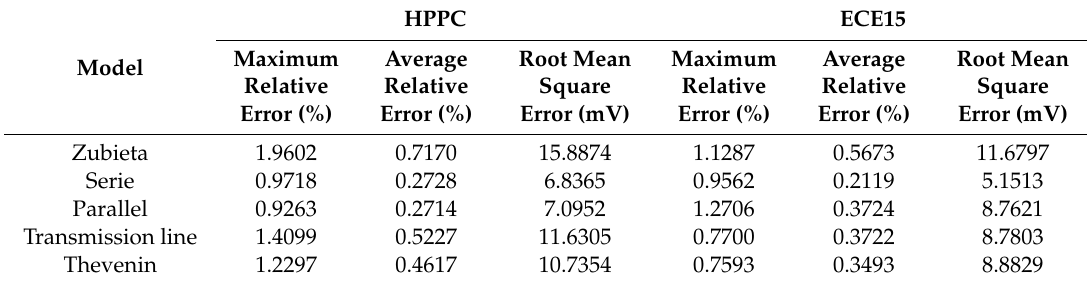
Table 6. The statistical metric with Current Profile i 3